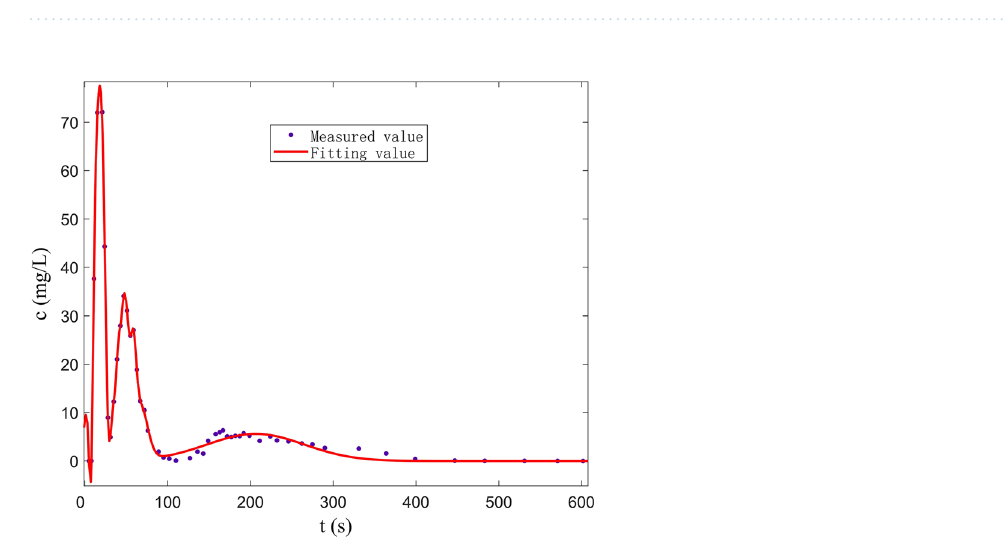
Table 4. Parameters determined by Gauss multi-peaks method with 95% confidence bounds (F 1 –C 2 –D 2 ).